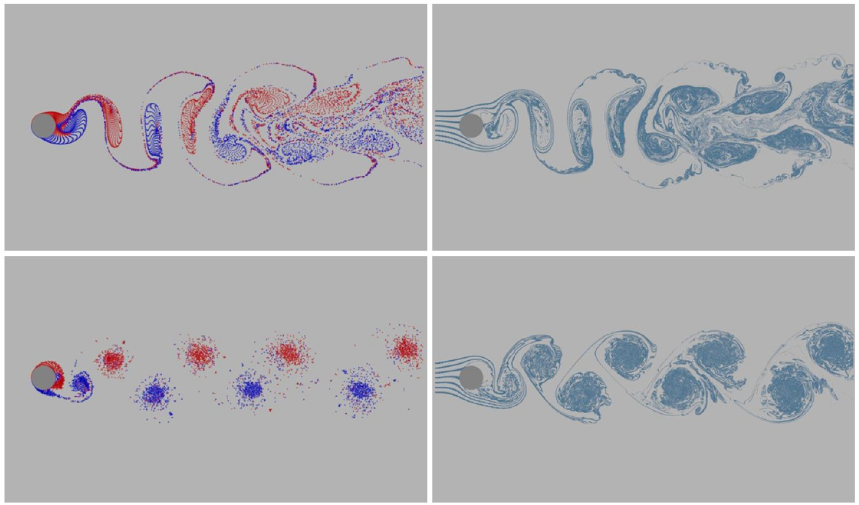
Fig 9. Comparison of Karman vortex street examples using different boundary treatment methods. The first row: the panel method; the second row: our boundary treatment method. Blue and red represent the vortex particles with negative and positive vorticity, respectively. Mineral blue represents the tracer particles.